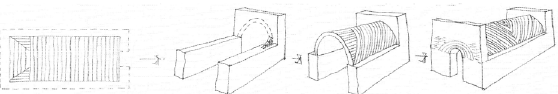
Figure 7. How does the Barrel vault run? author.